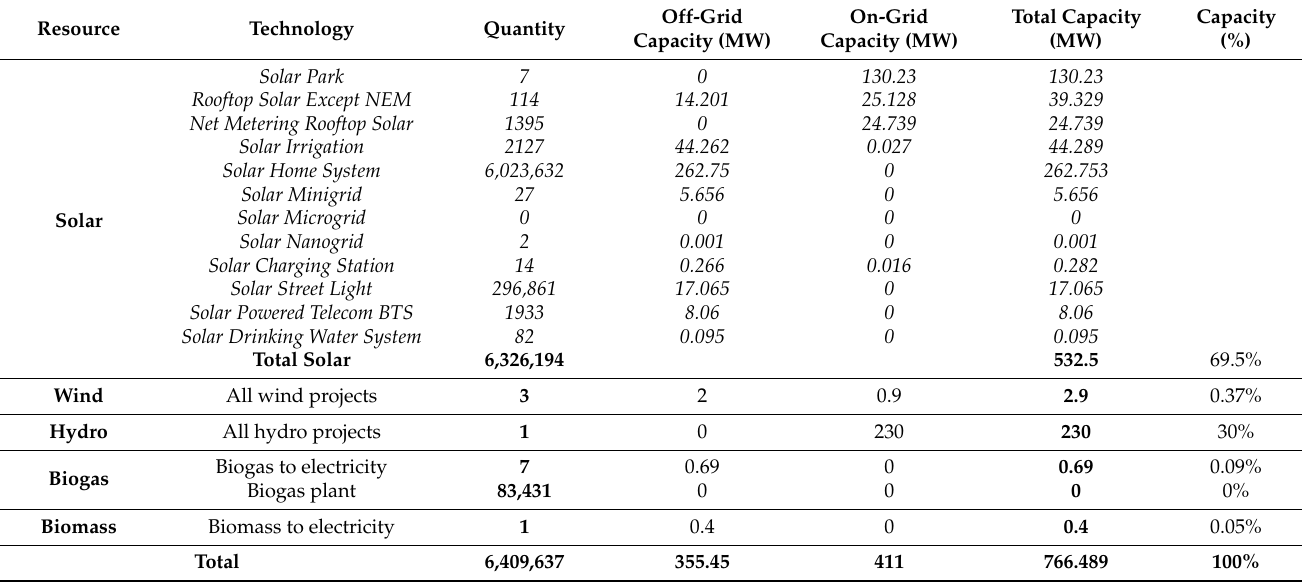
Table 4. Present status of installed RE (completed and running) capacity from diverse sources in Bangladesh (authors creation based on SREDA data